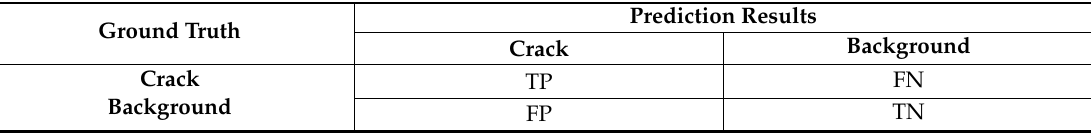
Table 3. The detailed description of TP, FP, TN,